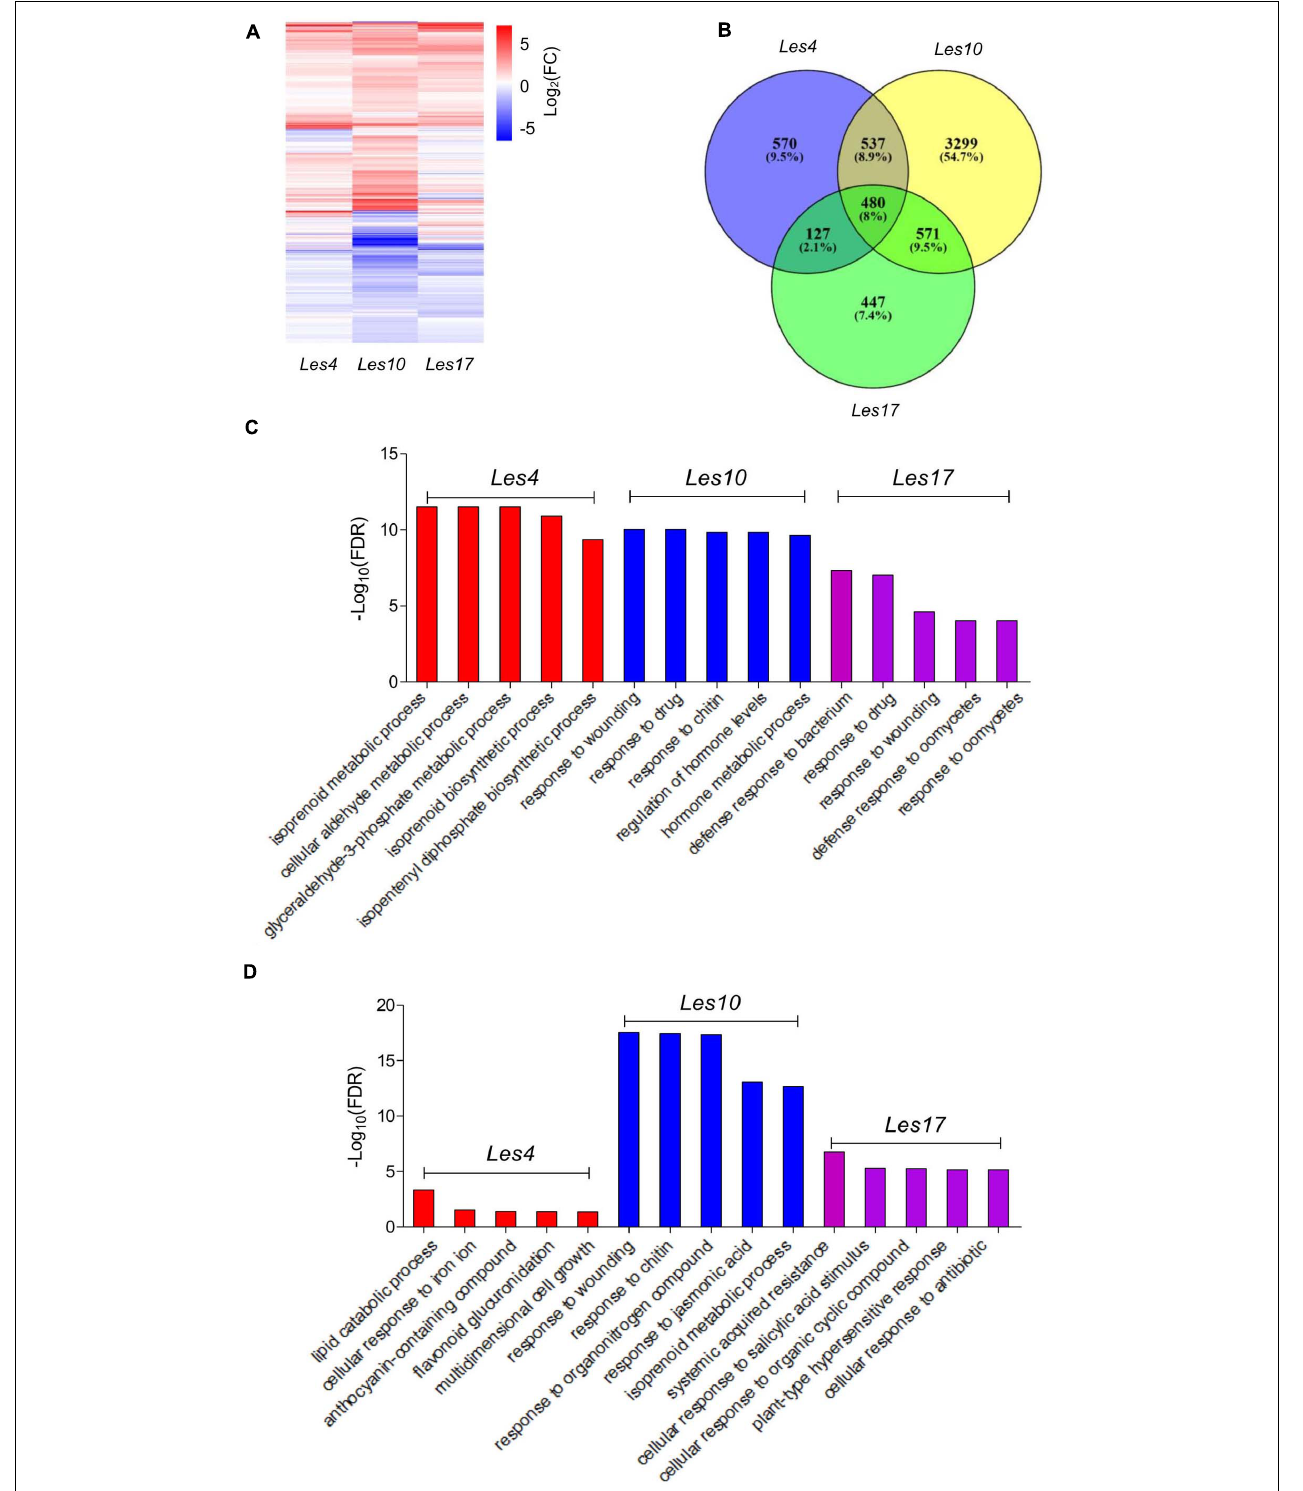
FIGURE 2 | Transcriptomic analysis of Les4 , Les10 , and Le17 . (A) Heatmap showing the differentially expressed genes (DEGs) in Les4 , Les10 , and Les17. (B) Venn diagram displaying DEGs unique and common in mutant vs. wild type in Les4 , Les10 , and Les17. (C) The top 5 GO terms of GO analysis of all DEGs in Les4 , Les10 , and Les17. (D) The top 5 GO terms of GO analysis of specific DEGs in Les4 , Les10 , and Les17 .